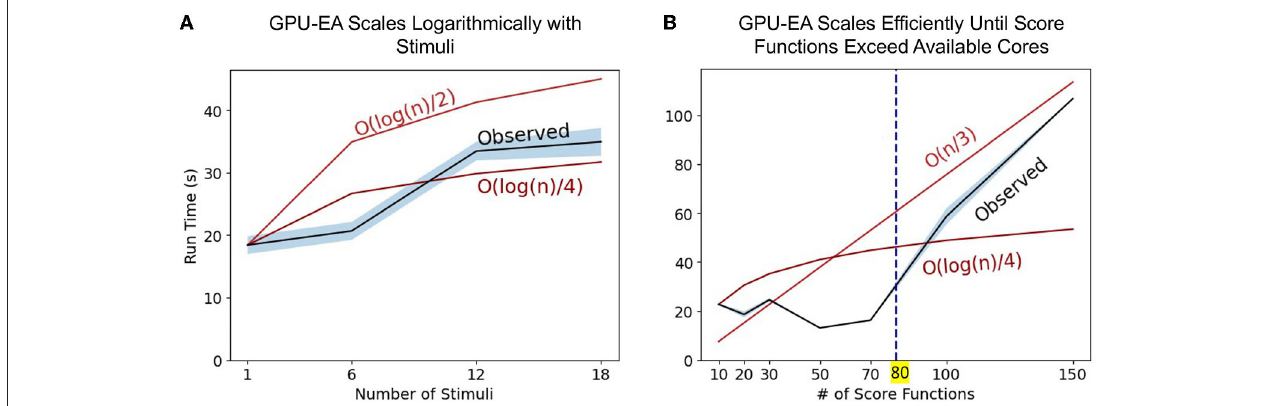
FIGURE 5 | Scaling stimuli and electrophysiological scoring functions: Panel (A) represents the observed run time as the number of stimuli used in the algorithm increases. We provide two lines for scaling reference O ( log ( n ) algorithm increases. We provide two lines for reference, O ( n